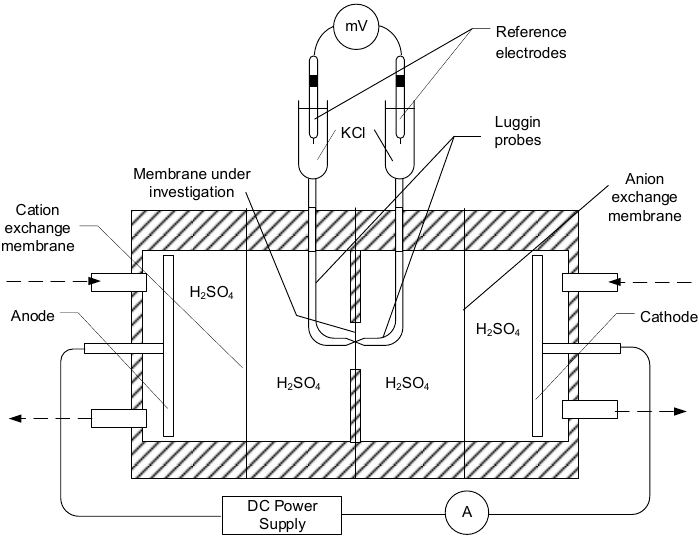
Figure 2. Schematic of the apparatus for measuring proton conductivity of membranes. Adapted from [26].